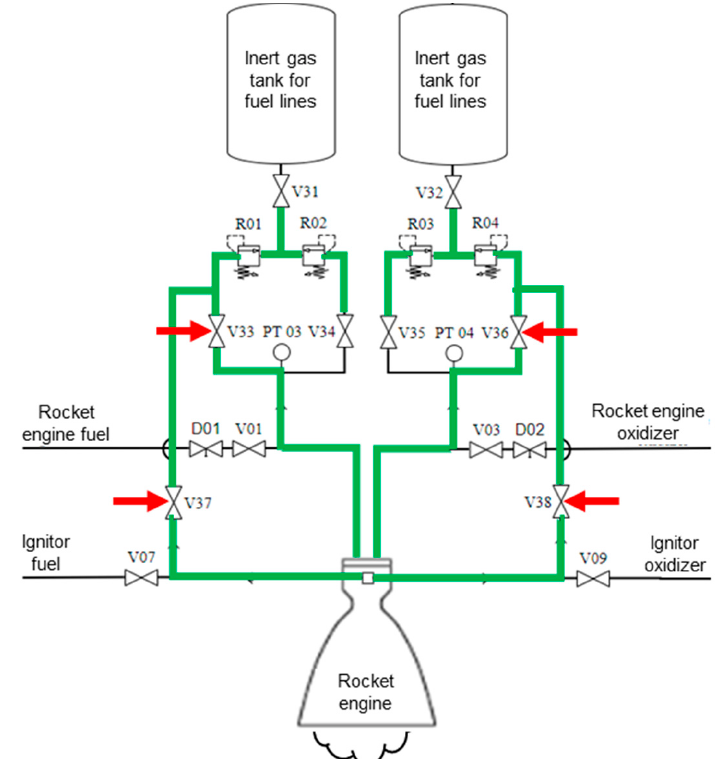
Figure 15. Algorithm’s fourth step diagram.